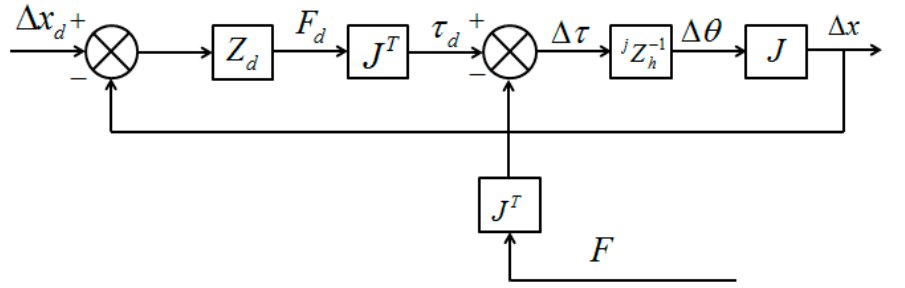
Figure 8. Open-loop impedance controller for the Phantom Premium.